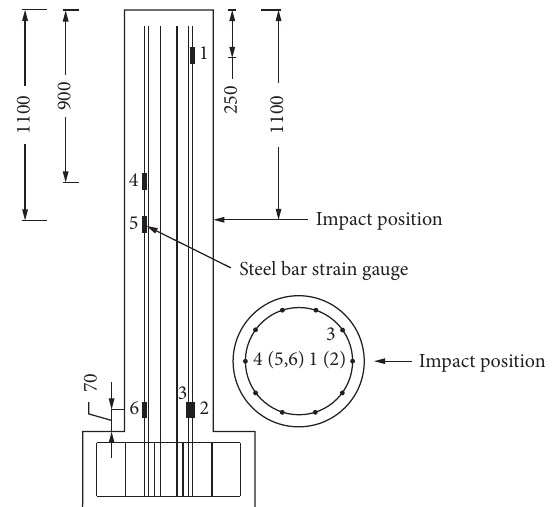
Figure 7: Distribution of the reinforcement strain measurement points.